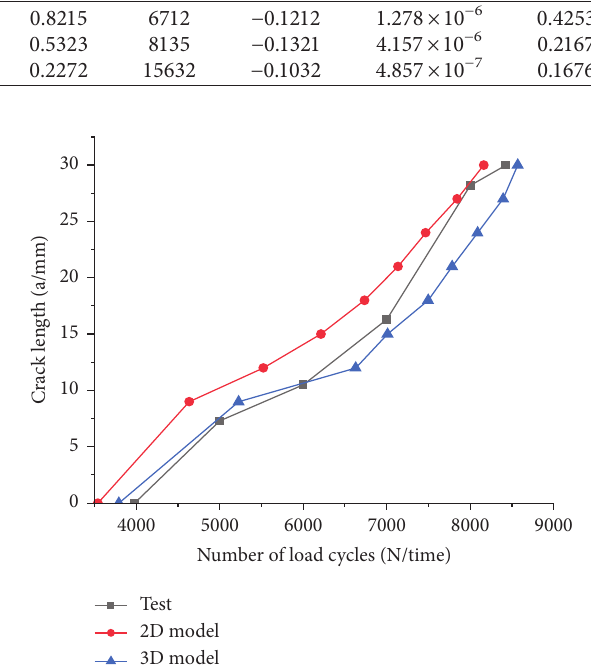
Figure 7: Crack propagation curves based on the crack pouring treatment.